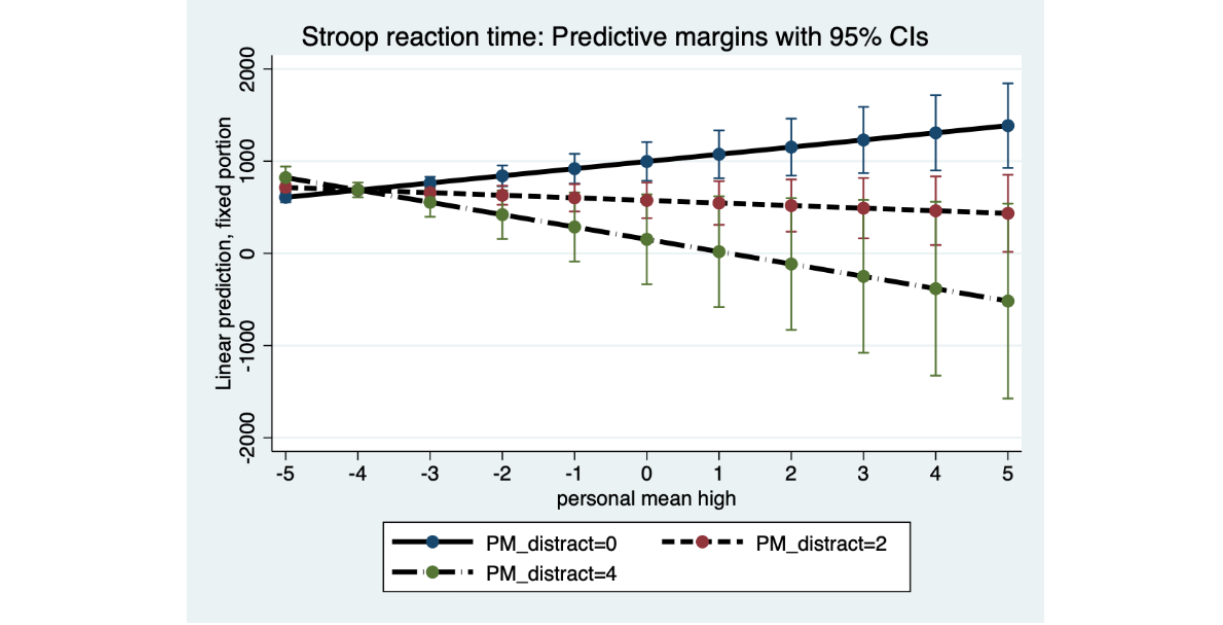
Figure 4. Marijuana Stroop: distraction person mean (PM) as a moderator of the association between subjective high PM and reaction time. Distraction PM at low (0), moderate (2) and high levels (4). PM: person mean.